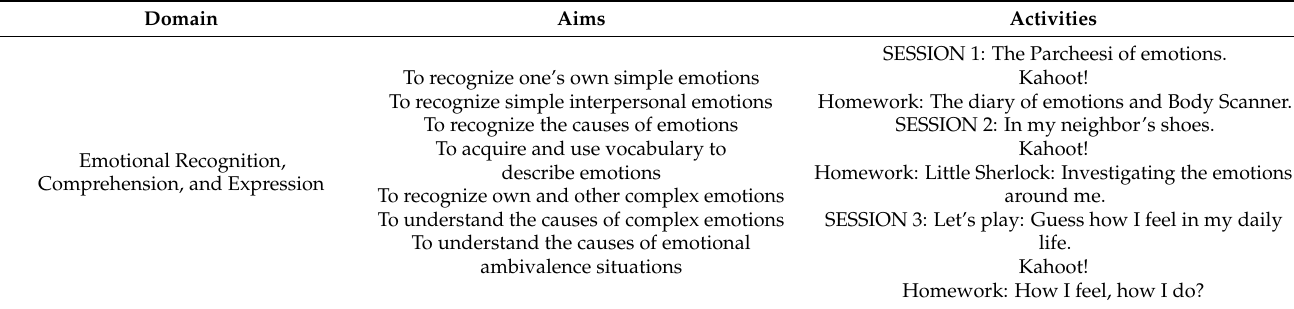
Table 2. Summary of “Exciting School”